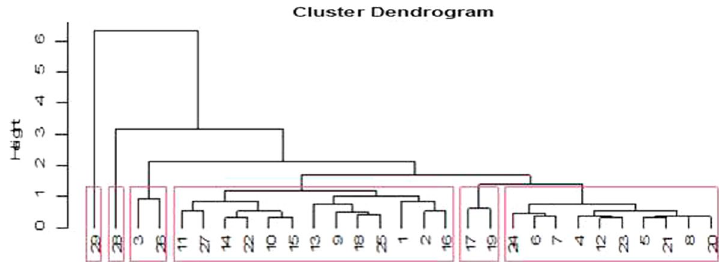
Fig. 5 Cluster dendrogram with spatiotemporal correlation in Stage 4. Note The numbers 1, 3, 12, 14, 16, and 23, 26 denote stock indices in developed markets; the remaining numbers denote indices in developing markets, according to Tables 2 and